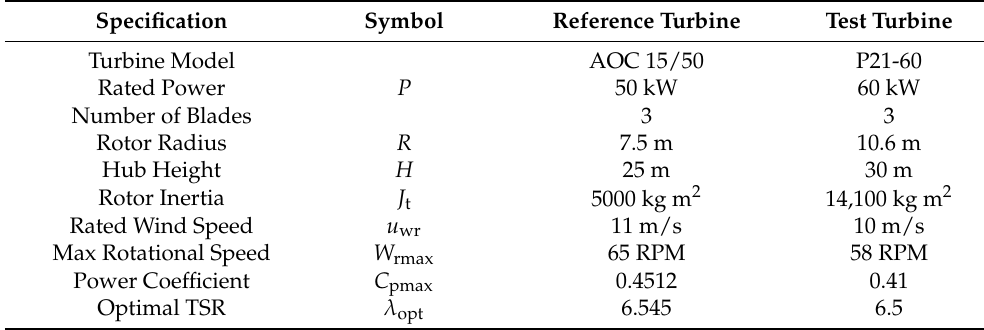
Table 2. Test turbine data and its comparison with an NREL